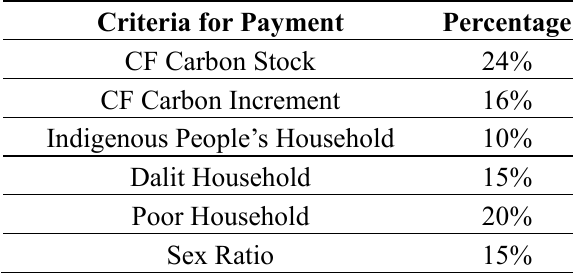
Table 3. Criteria for making pilot reducing emissions from deforestation and forest degradation (REDD+) payments to community.